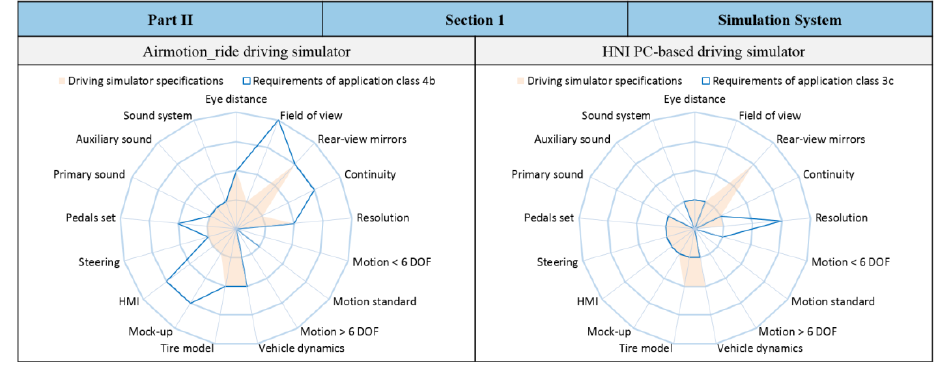
Figure 17. Specification/requirement radar charts of the selected system components.